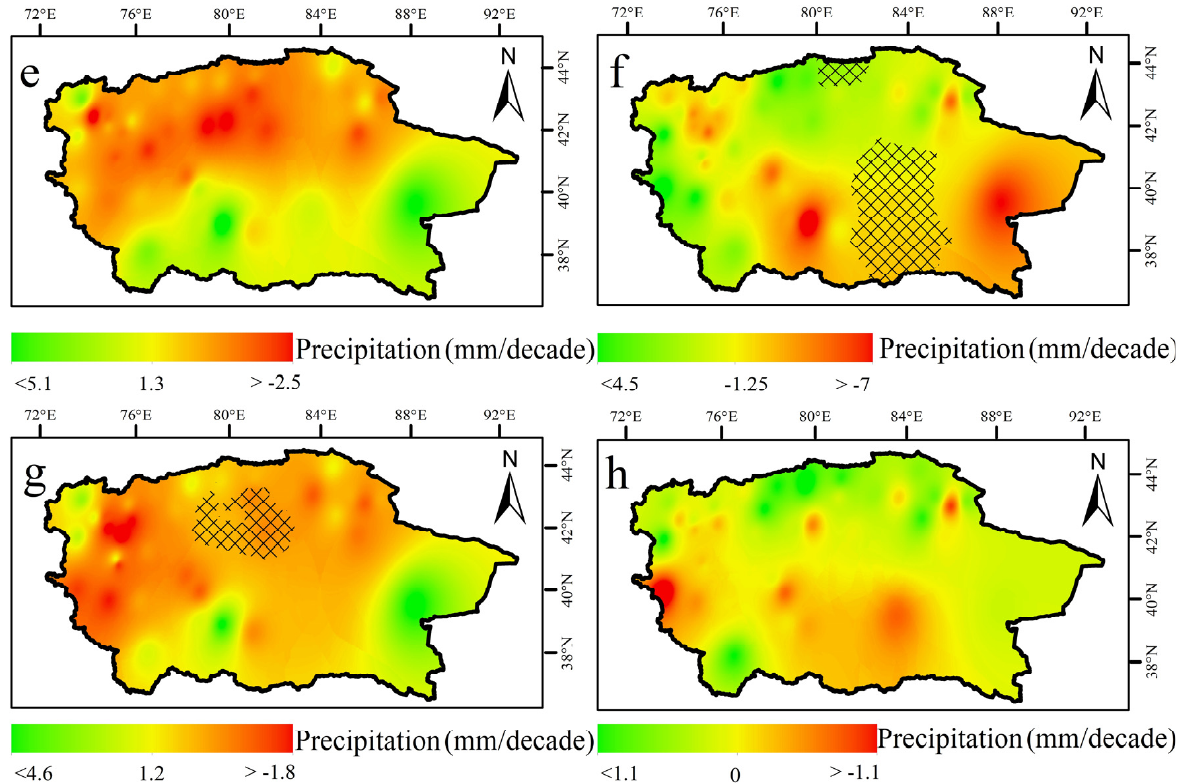
Figure 4. Spatial variations in seasonal climate change in the Tarim Basin. ( a – d ) Temperature variations in spring, summer, autumn, and winter, respectively. ( e – h ) Precipitation variations in spring, summer, autumn, and winter, respectively (The black grid indicates that the trends are statistically significant at the 0.05 level).